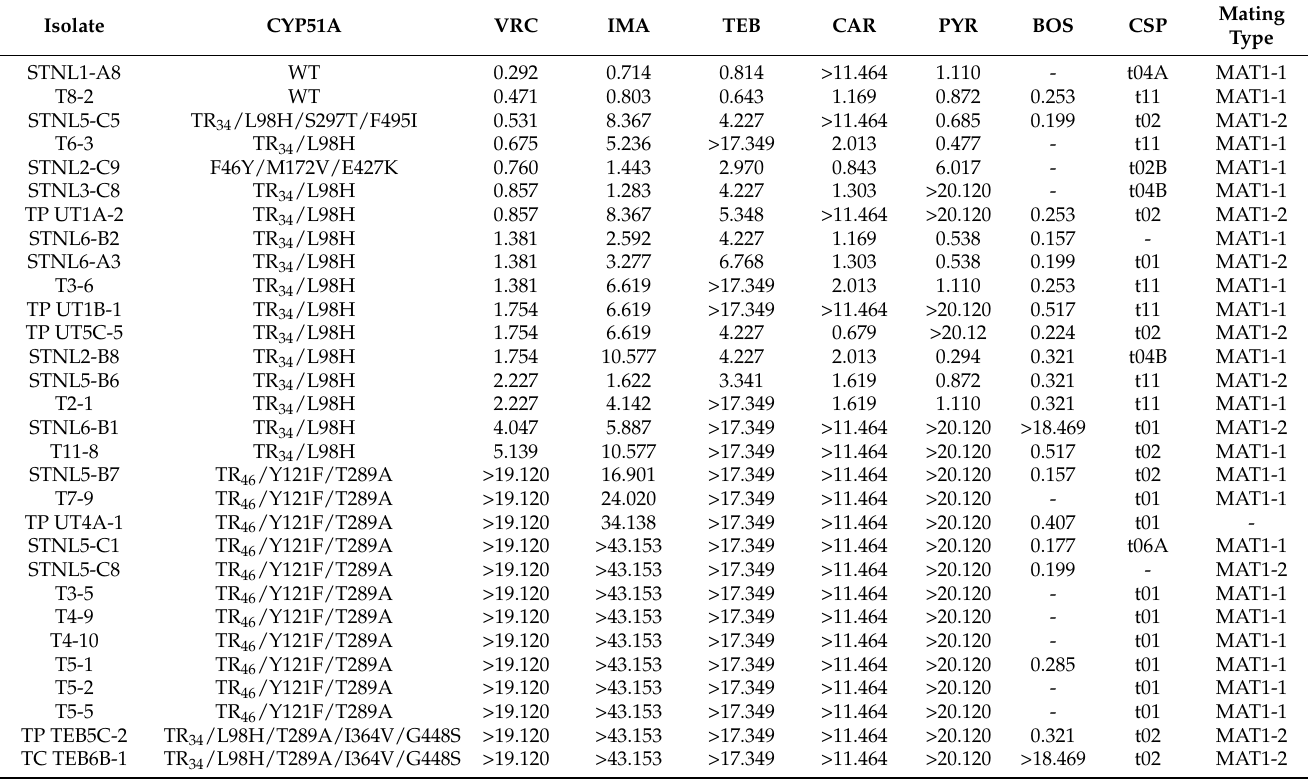
Table 2. Sensitivity of environmental Aspergillus fumigatus isolates to a panel of fungicides belonging to different modes of action and their further characterization using CSP, mating type and CYP51A variant analysis. Isolates ranked according to voriconazole sensitivity (low to high MIC values in µ